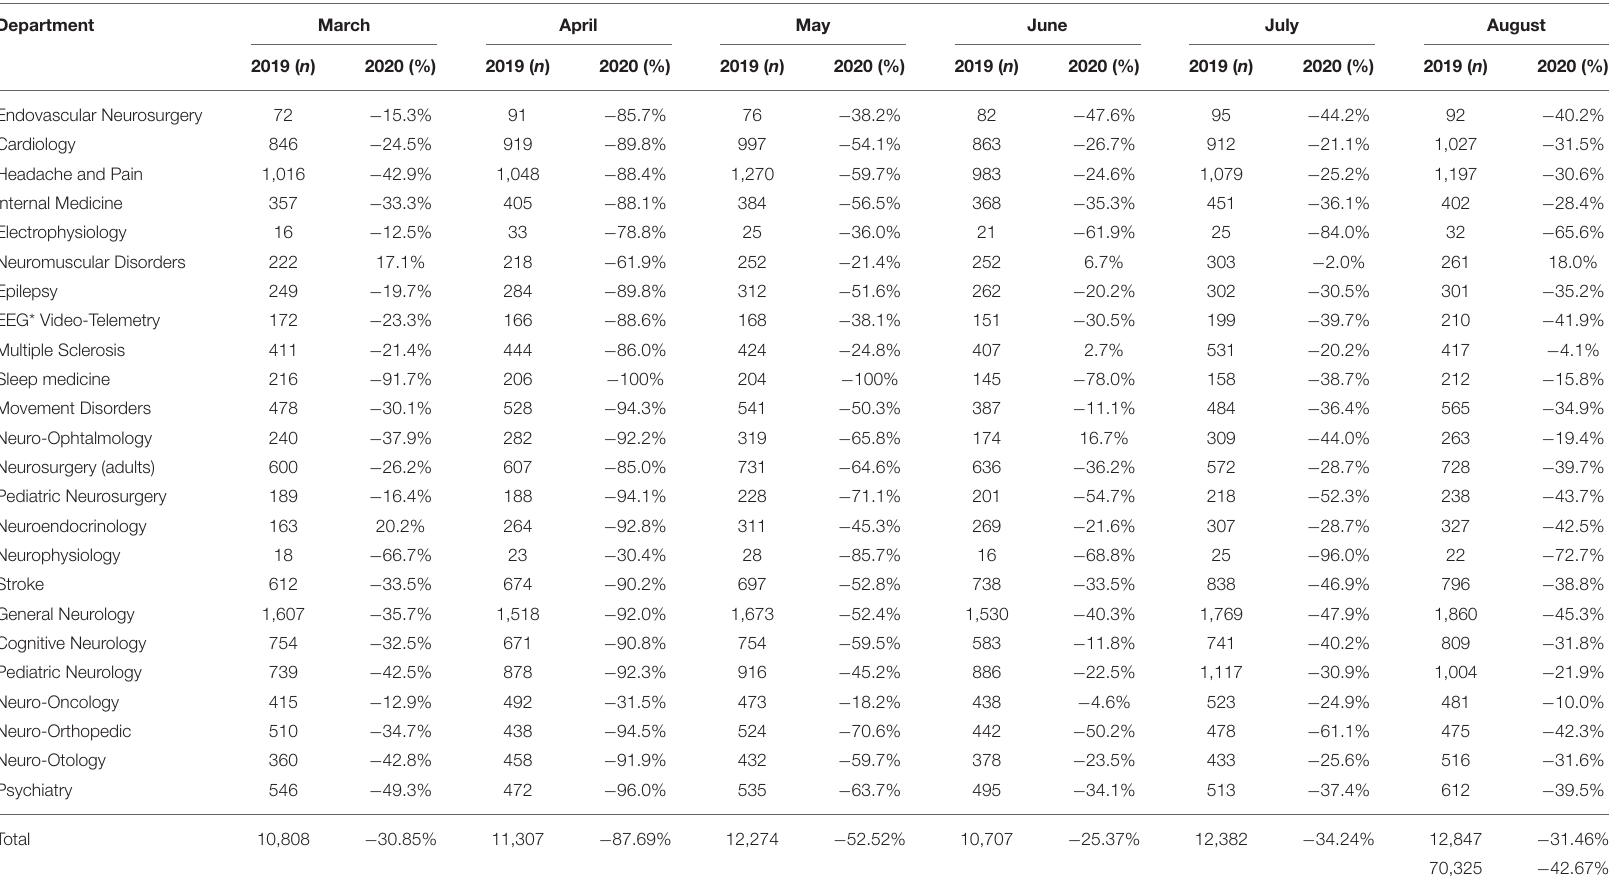
TABLE 1 | Percentage reduction in outpatient visits according to month and neurological